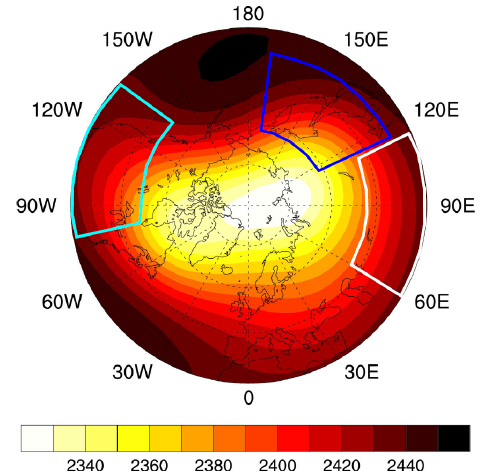
Figure 2. Geopotential height of the Ref simulation averaged between 20 and 30km northward of 30 ◦ . Positions of the respective GW hotspots. Blue box—East Asia (EA); white box—Himalayas (HI); cyan box—Rocky Mountains